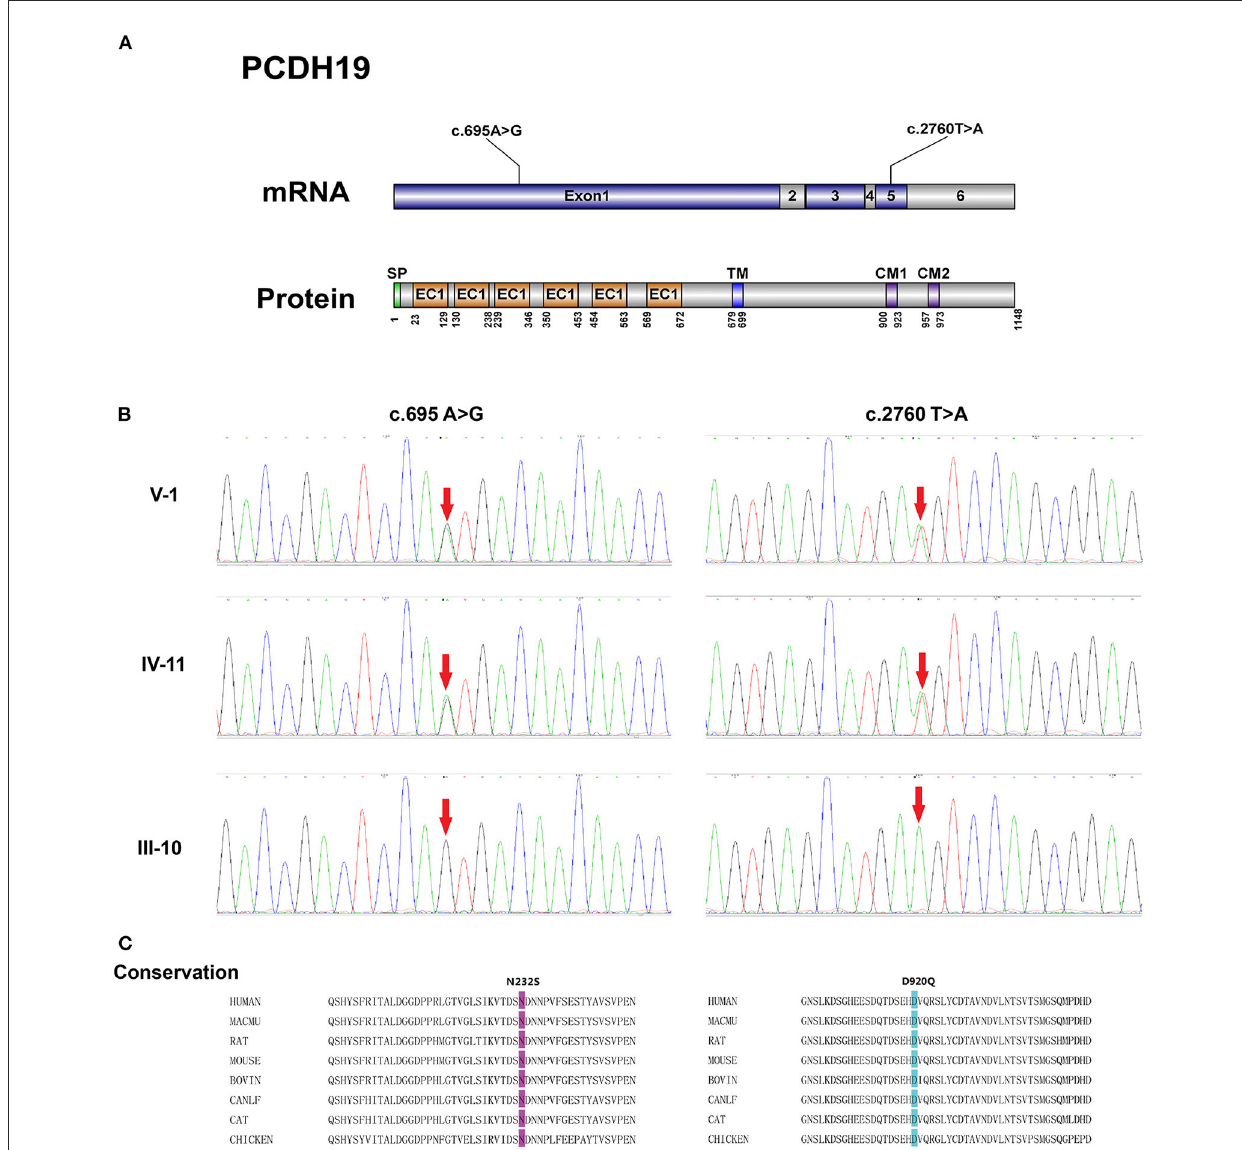
FIGURE2 (A) Schematic representation of the structure of PCDH19 mRNA and protein with two gene mutation sites identified in our pedigree. SP, signal peptide; EC, extracellular cadherin domain; TM, transmembrane domain; CM 1 and CM 2, cytoplasmic domains 1 and 2. (B) Electropherograms of Sanger sequencing of the PCDH19 mutations: c.695A > G and c.2760T > A. (C) Alignment of the p.N232S and p.D920Q mutations among PCDH19 orthologs in different